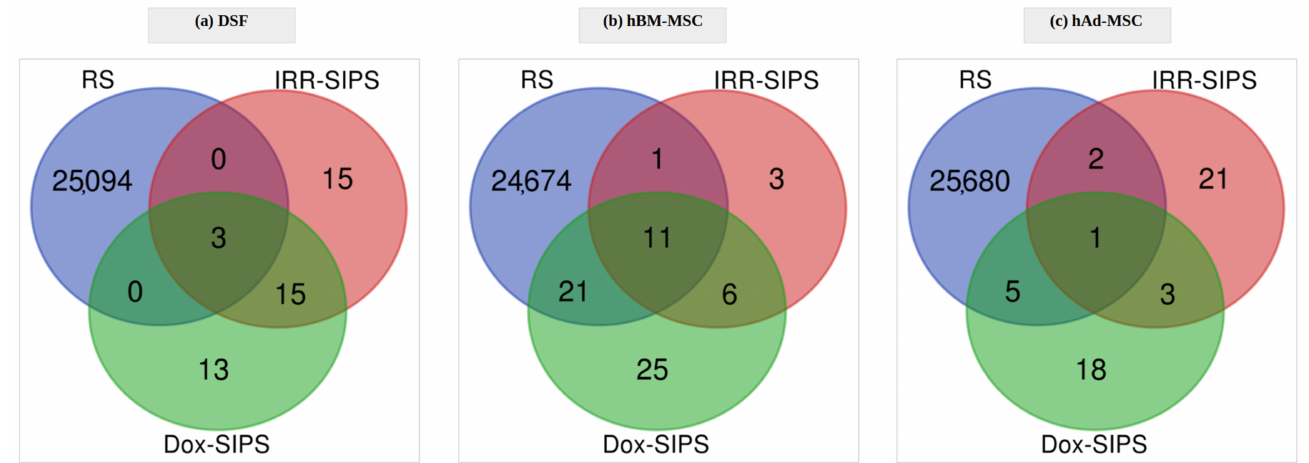
Figure 2. Differentially methylated position overlaps among the three types of senescence (replicative senescence RS, stress-induced premature senescence after exposure to ionizing irradiation IRR-SIPS and doxorubicin Dox-SIPS) in ( a ) DSF, ( b ) hBM-MSC and ( c )